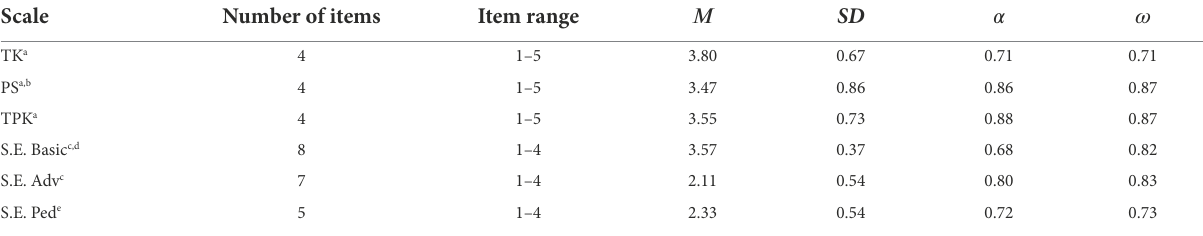
TABLE 1 Scale characteristics of the final